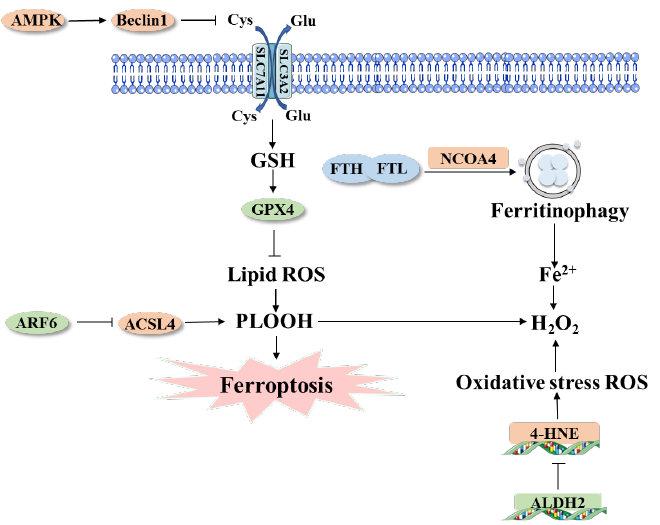
Figure 3. Mechanism of ferroptosis involved in PDAC. Ferroptosis is an iron-dependent cell death driven by lipid peroxidation. There are multiple ways to regulate the level of ferroptosis in PDAC cells, such as transcription factors, autophagic degradation and metabolic pathways. System xc - and GPX4 act as the key regulators in the process of ferroptosis in PDAC. AMPK-Beclin1 pathway trigger ferroptosis by inhibiting system xc - . Irisin serves as a suppressor of ferroptosis by increasing the accumulation of lipid reactive oxygen and the depletion of GSH. NCOA4 accumulates in lysosomes and then promotes ferritinophagy, leading to iron accumulation and, ultimately, ferroptosis. ARF6 increases the expression of ASCL4 and induces ferroptosis by increasing the expression of PLOOH. ALDH2 decreases 4-HNE production in PDAC cells and blocks the ferroptosis pathways by reducing oxidative stress ROS. Abbreviations: GSH, glutathione; GPX4, glutathione peroxidase 4; PDAC, pancreatic ductal adenocarcinoma; AMPK, AMP-activated protein kinase; NCOA4, nuclear receptor coactivator 4; ACSL4, acyl coenzyme A (CoA) synthetase long-chain family member 4; ALDH2, aldehyde dehydrogenase 2; 4-HNE, 4-hydroxy-2-nonenal; ROS, reactive oxygen species.